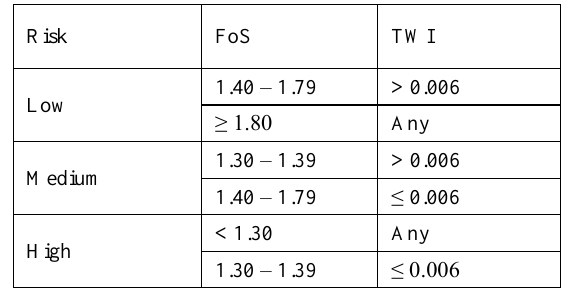
Table 1. Thresholds for cross-section risk